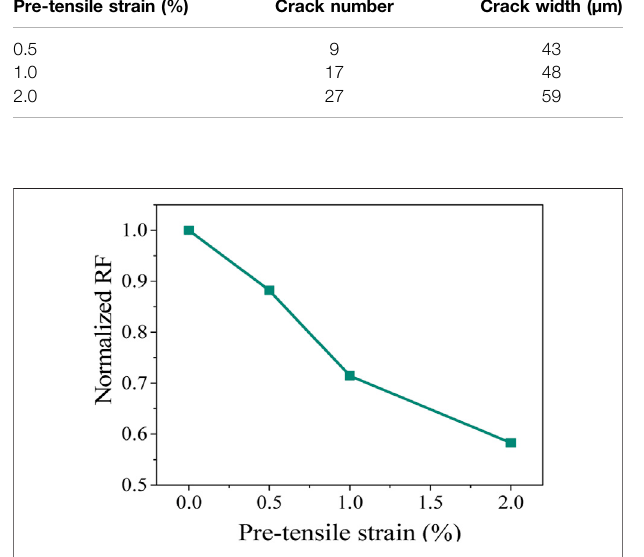
FIGURE 8 | Normalized RF of pre-damaged CR2-0.4. RF, resonant frequency.